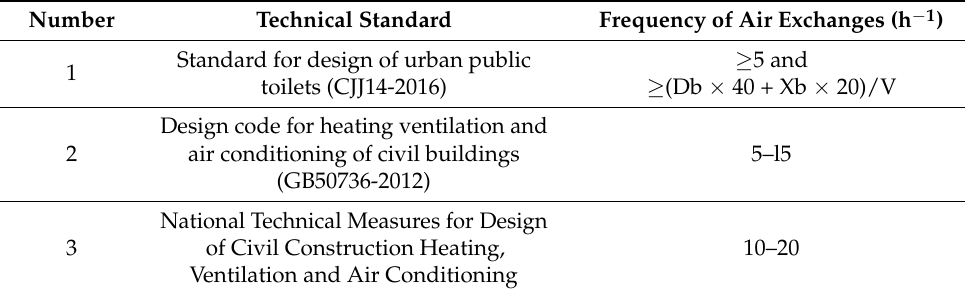
Table 1. Recommended ventilation parameters for public